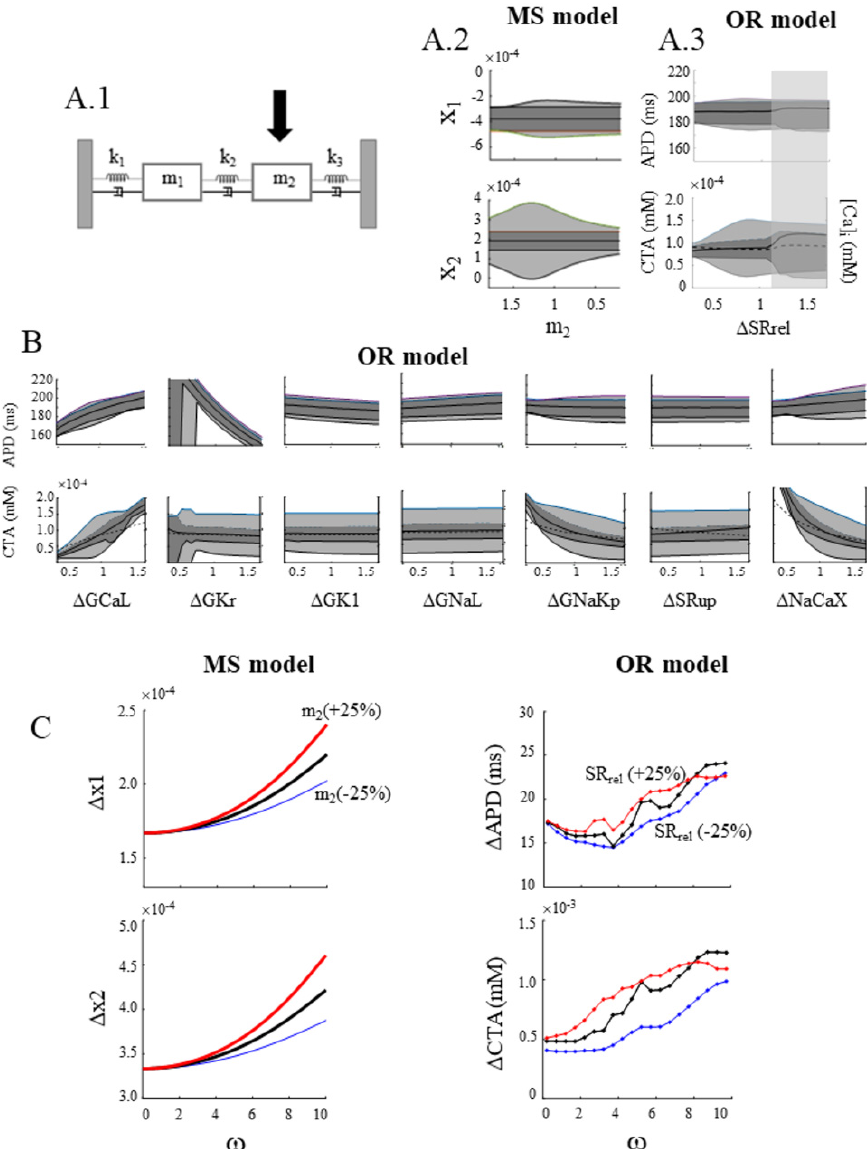
Figure 11. SR calcium release and inertia of cal – C compartment. The same representation of Figure 10 is provided for x 1 and x 2 oscillation amplitudes when m 2 increases or decreases (panels ( A1 ) and ( A2 )). The same behavior is observed in oscillation amplitudes of APD and CTA of the OR model when SR calcium release undergoes ± 50% changes (panel ( A3 )). Analogous representation was measured in the OR model for changes in a number of maximum conductance of ion currents and membrane transporters (panel ( B )). Panel ( C ), left column shows the left (right)shift of the resonant profile of the MS model for x 1 and x 2 oscillation amplitudes when m 2 was increased (decreased) by 25%. Panel C, right shows the left (right) shift of the ω dependence of APD and CTA oscillation amplitudes (BCL = 300 ms) when the flux through SR release channels was increased (decreased) by 25%. Panel A.2 summarizes the expected changes in ∆ x 1 and ∆ x 2 when m 2 of the MS model (panel A.1) is increased or decreased around its control value (Table 2). When I derive the same representation by testing, in the OR model, ± 50% changes in a number of ion currents, transporters, and calcium fluxes (panels A3 and B), I find that the one that more closely reproduces m 2 changes is that corresponding to the modulation of the SR calcium flux to the cytoplasm. The shaded area in panel A3 represents conditions where CTA